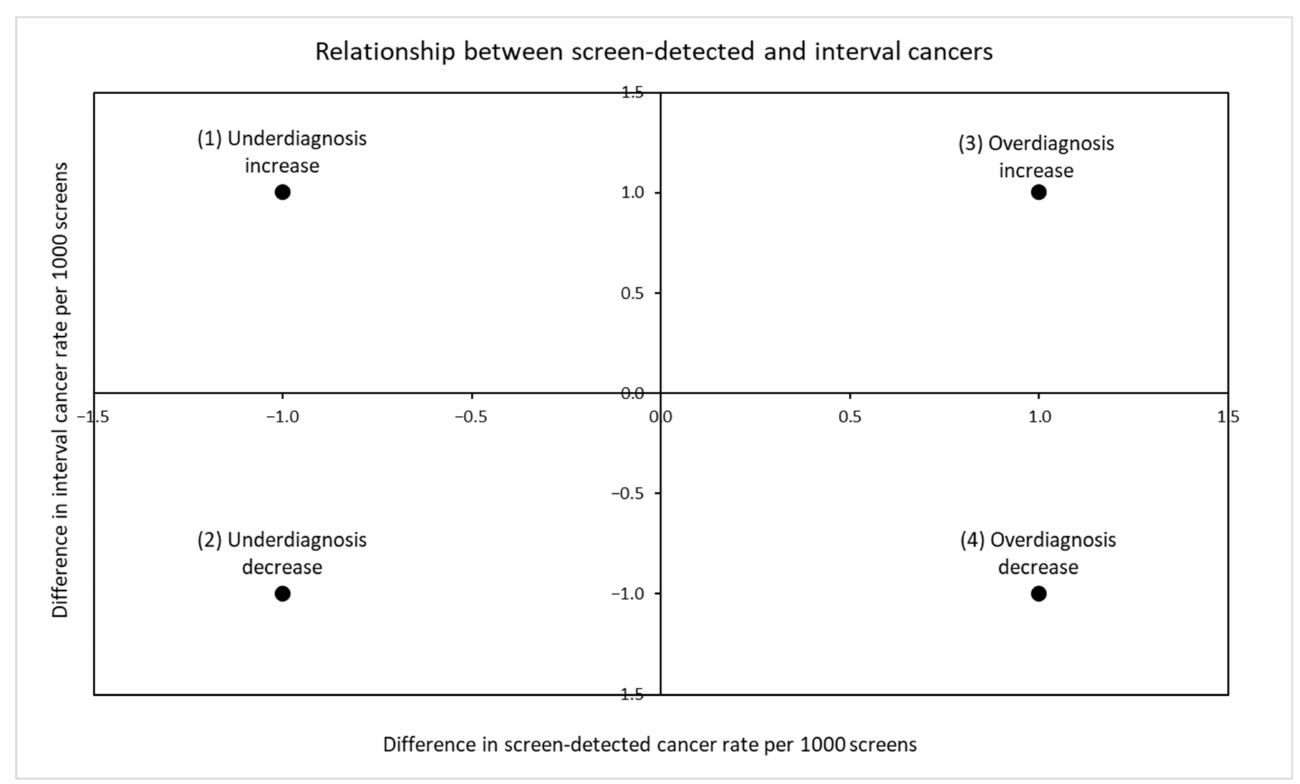
Figure 2. Indications from the relationship between screen-detected and interval cancer rates subse- quent to a change in a screening